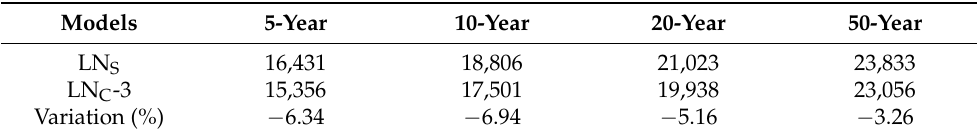
Table 4. The design flood values comparison between stationary and climate-based nonstationary conditions Unit: m 3